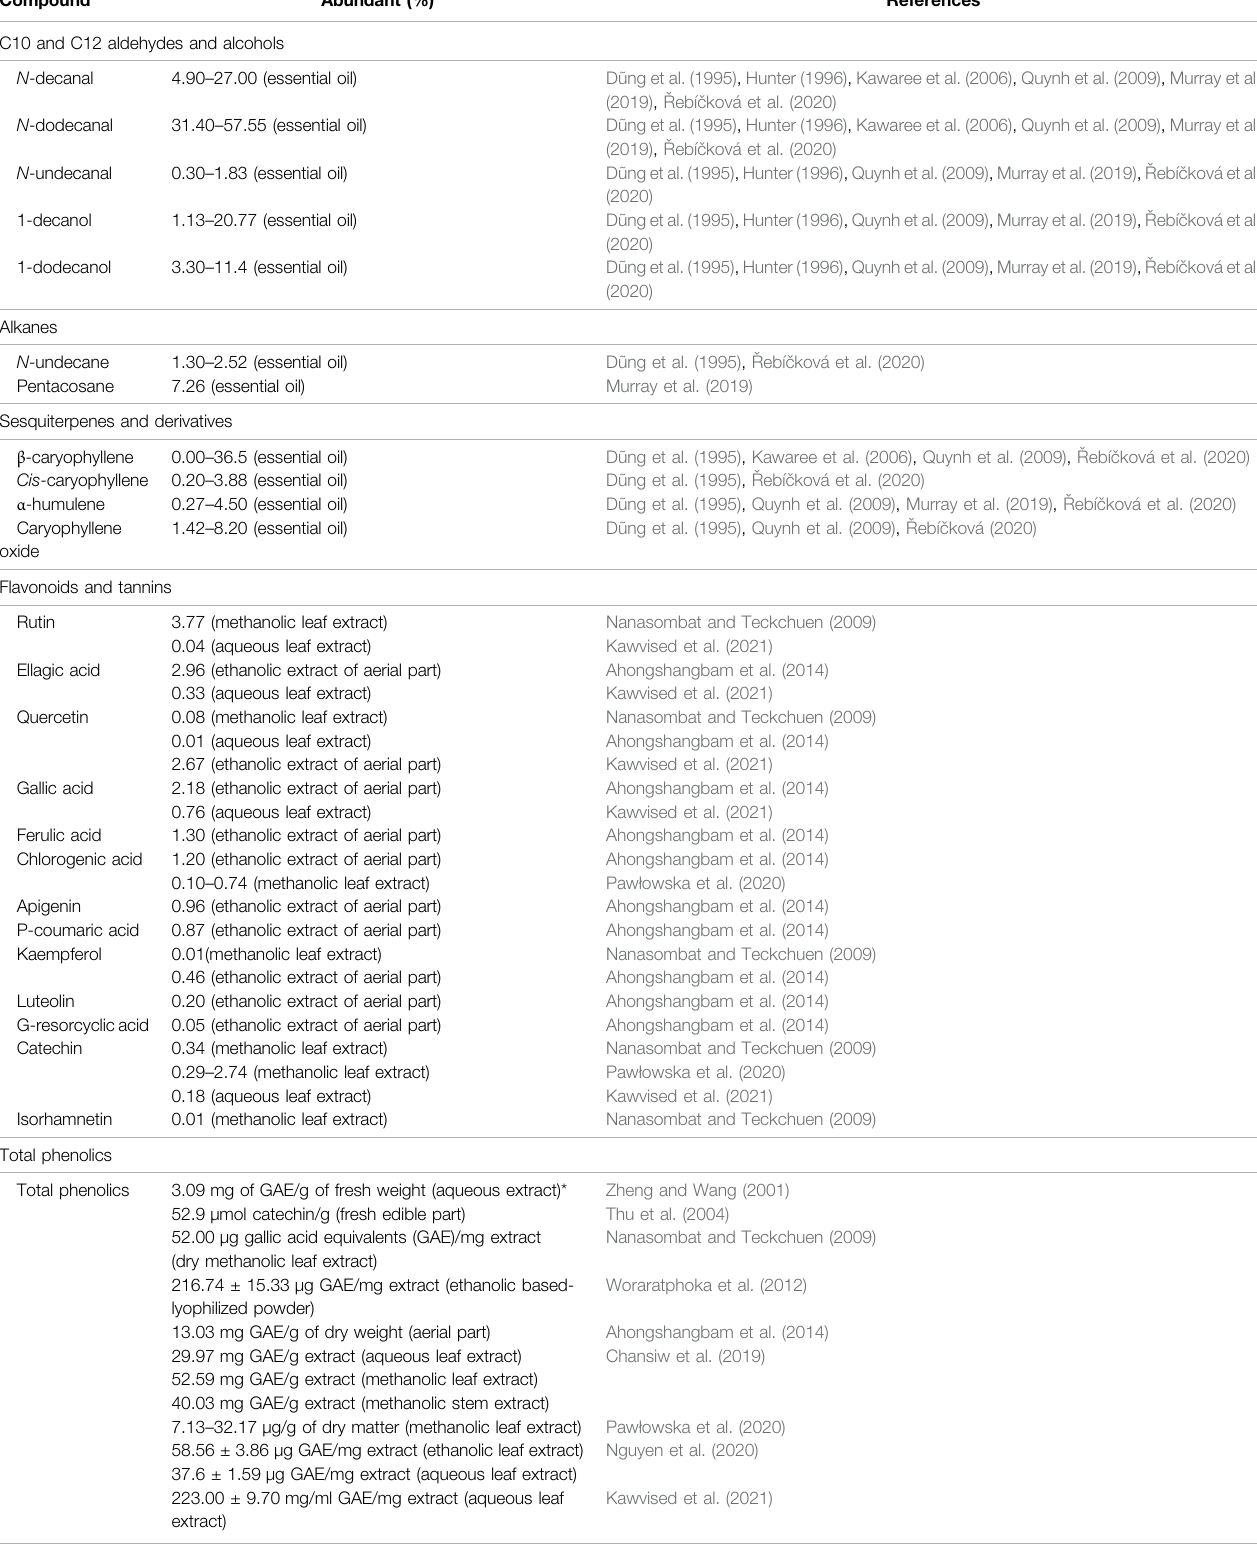
TABLE 1 | Major phytochemicals found in the essential oil and extract obtained from P. odoratum . Compound Abundant